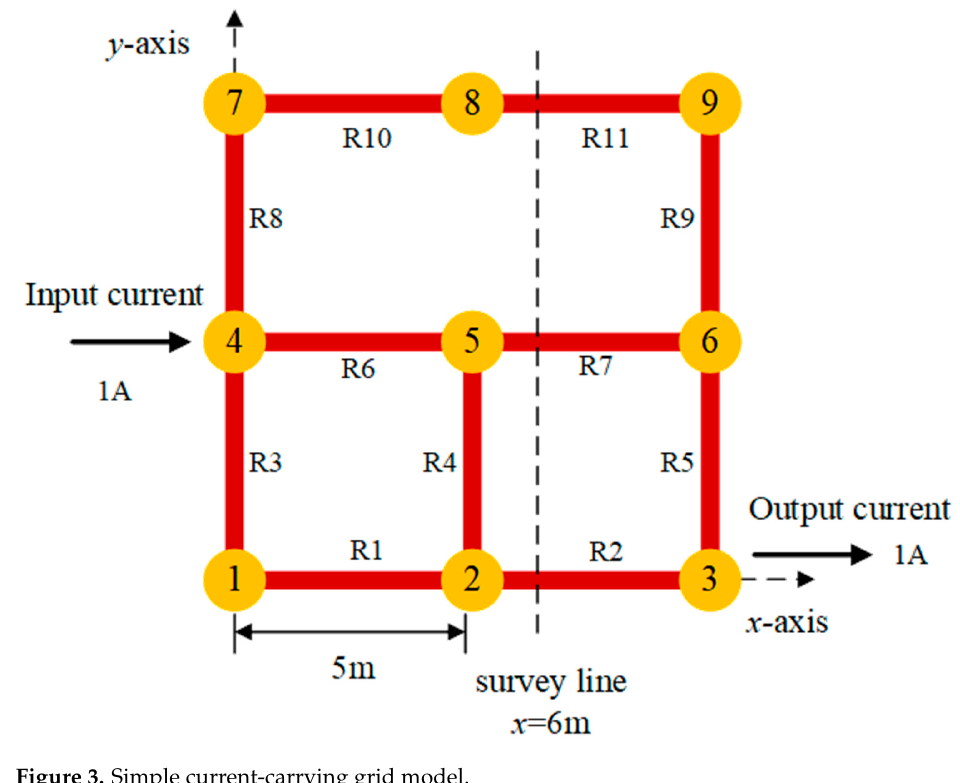
Figure 3. Simple current-carrying grid model.